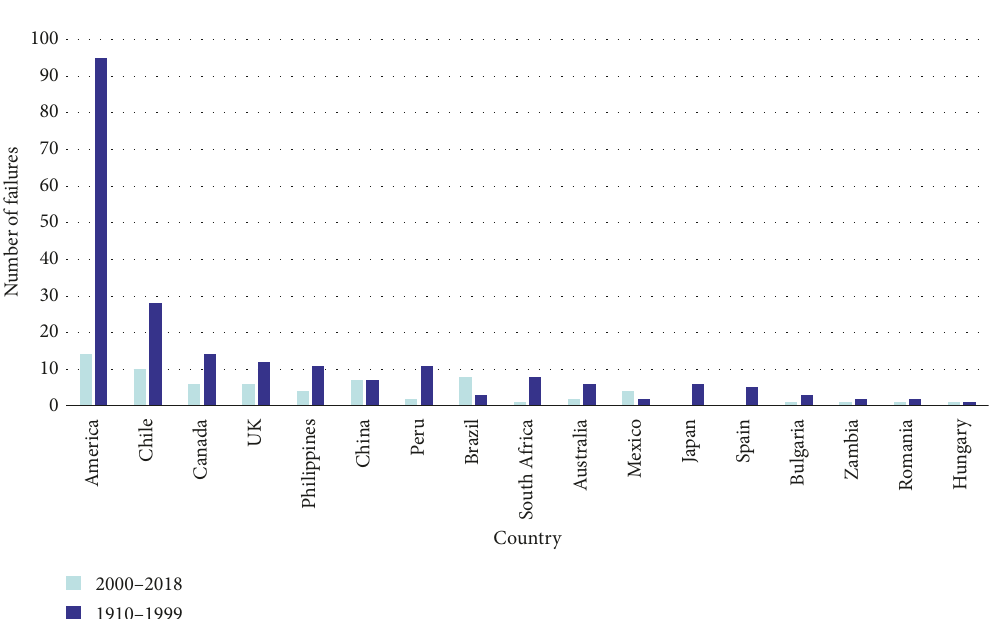
Figure 4: Failure distribution by country.